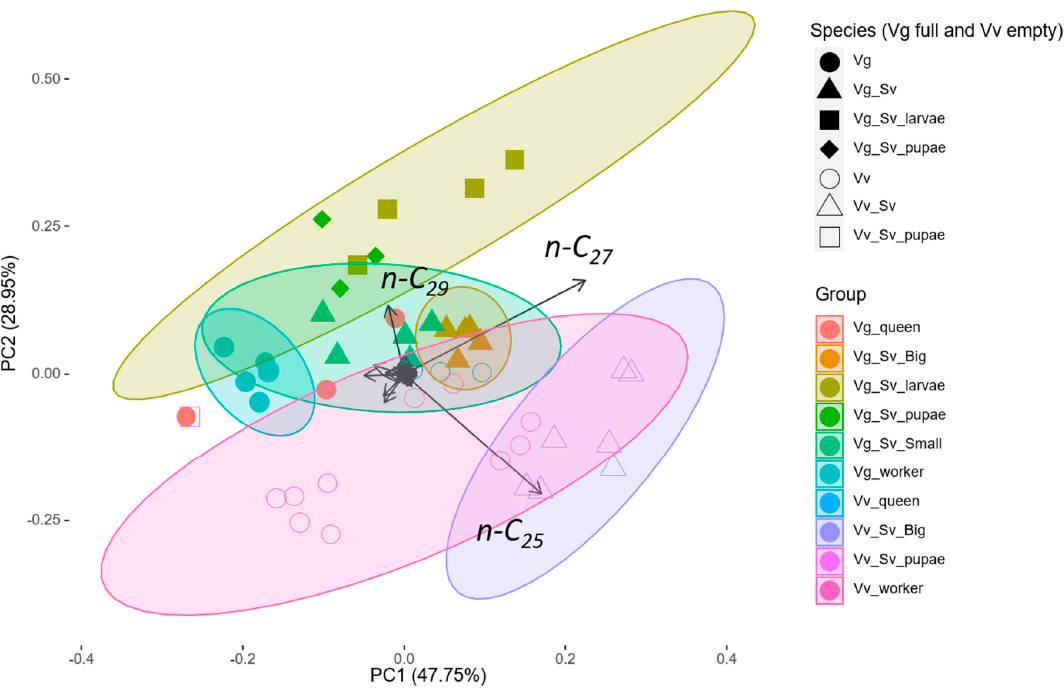
Figure 3. Principal component analysis (PCA) of the chemical profiles of the individuals. The host species from which the parasitoid sample was collected is indicated by a full (solid) symbol for the Vespula germanica nest and an empty symbol for the Vespula vulgaris nest. The groups represent each morpho-type by the colors. Vg: Vespula germanica , Vv: Vespula vulgaris , Sv: Sphecophaga vesparum , Big: winged S. vesparum , Small: brachypterous S. vesparum. Ellipses represent 95% confidence interval.